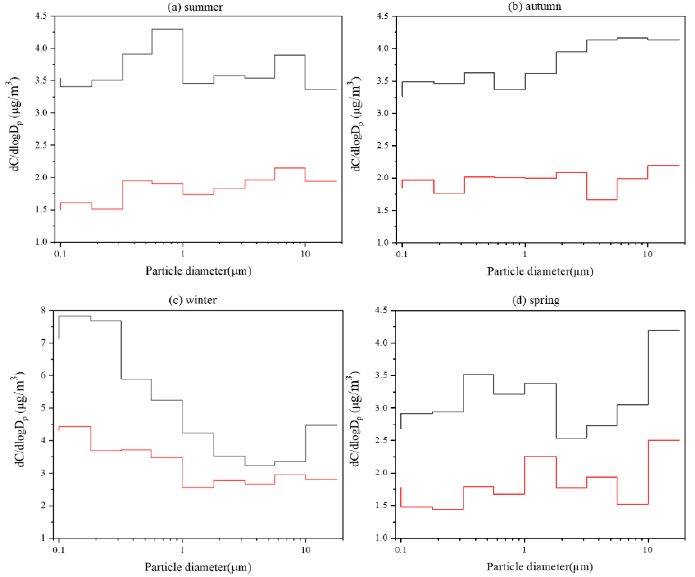
Figure 4. Size distribution of mean concentrations of WSOC (black lines) and HULIS-C (red lines) in different seasons.